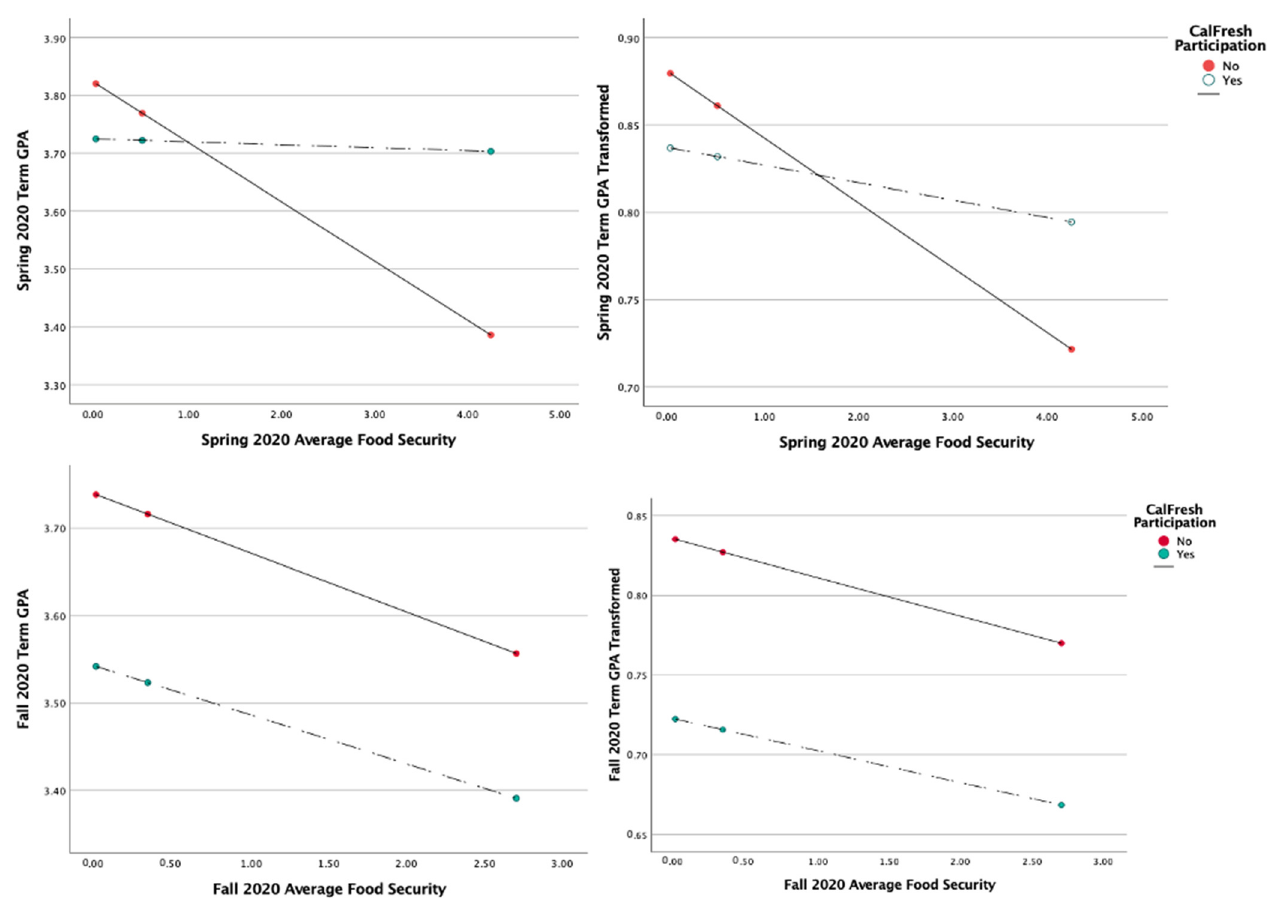
Figure 3. Full Moderation of CalFresh Participation on Average Food Security Score effect on Quarter GPA. Table 2. Full Moderation Model: Food Security Scores’ Effect on Quarter GPA with CalFresh Mod- eration.